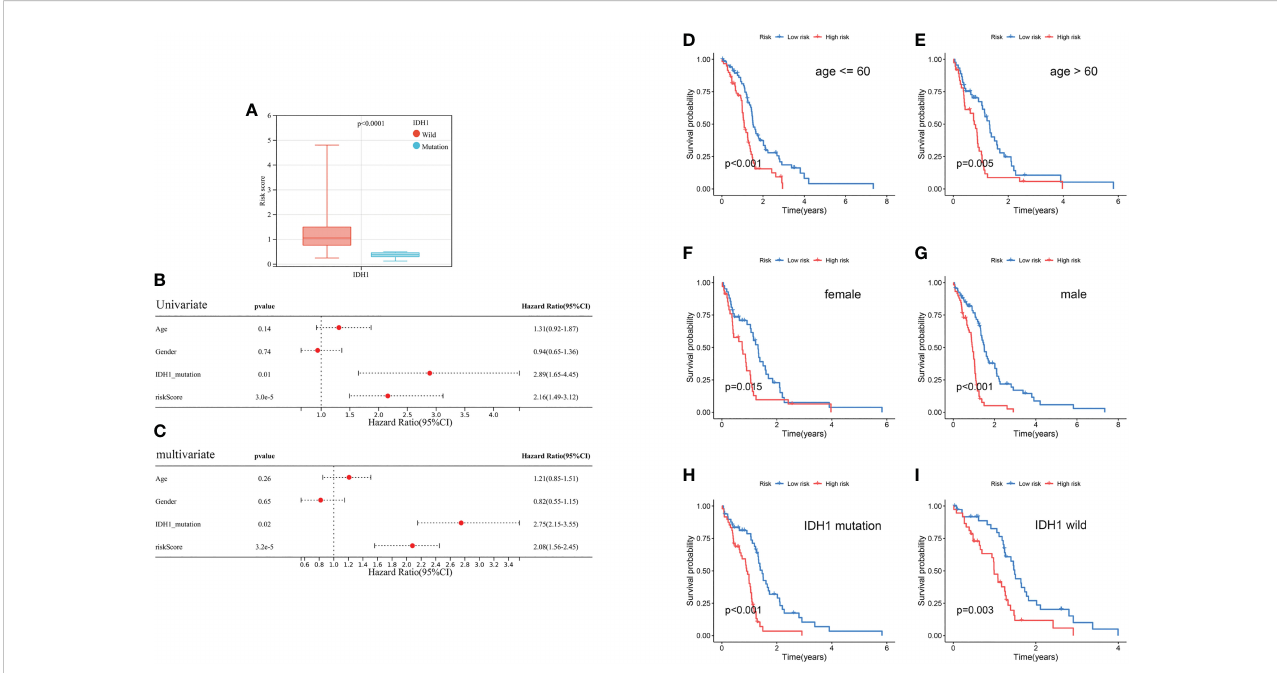
FIGURE 9 Clinical correlation analysis and strati fi cation analysis of the prognostic risk score. (A) The correlation between the risk score and IDH1 mutation status. (B, C) Univariate and multivariate analyses showed the prognostic value of the risk score and IDH1 mutation. (D, E) Strati fi cation analysis of the risk score in GBM. Age (age ≤ 60 and age > 60 years old). (F, G) Gender (female and male). (H, I) IDH1 mutation status (mutant type and wild